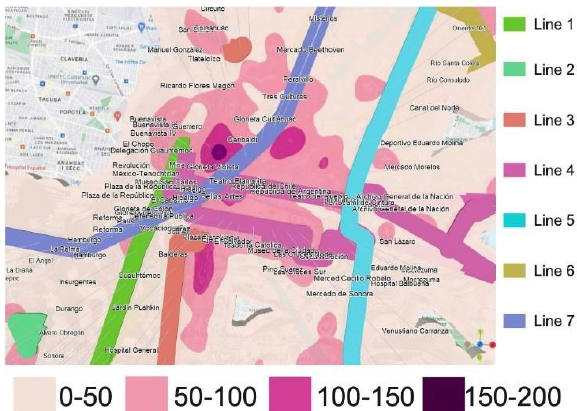
Figure 11. Heatmap of gender-based crimes on subwaybus lines in